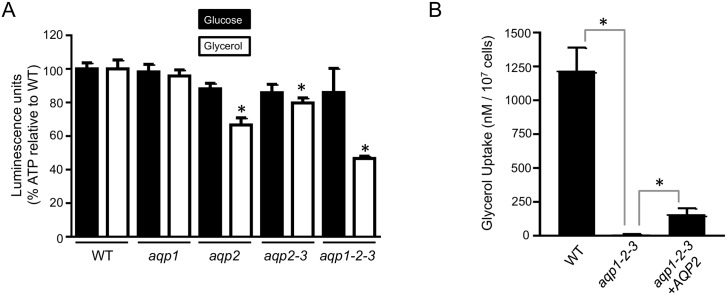
Glycerol uptake and utilisation is perturbed in aqp-null T. b. brucei.(A) ATP levels were assessed in the strains indicated after incubation in 5 mM glucose or glycerol. Readings were taken in triplicate and normalised to substrate only. * indicates significantly different (P<0.001) to wild-type (WT) using an ANOVA test in GraphPad Prism. Error bars, SD. (B) Radiolabelled glycerol uptake was assessed in the strains indicated. Readings were taken in quadruplicate. * indicates significant difference (P<0.05) using a Student’s t-test. Error bars, SD.